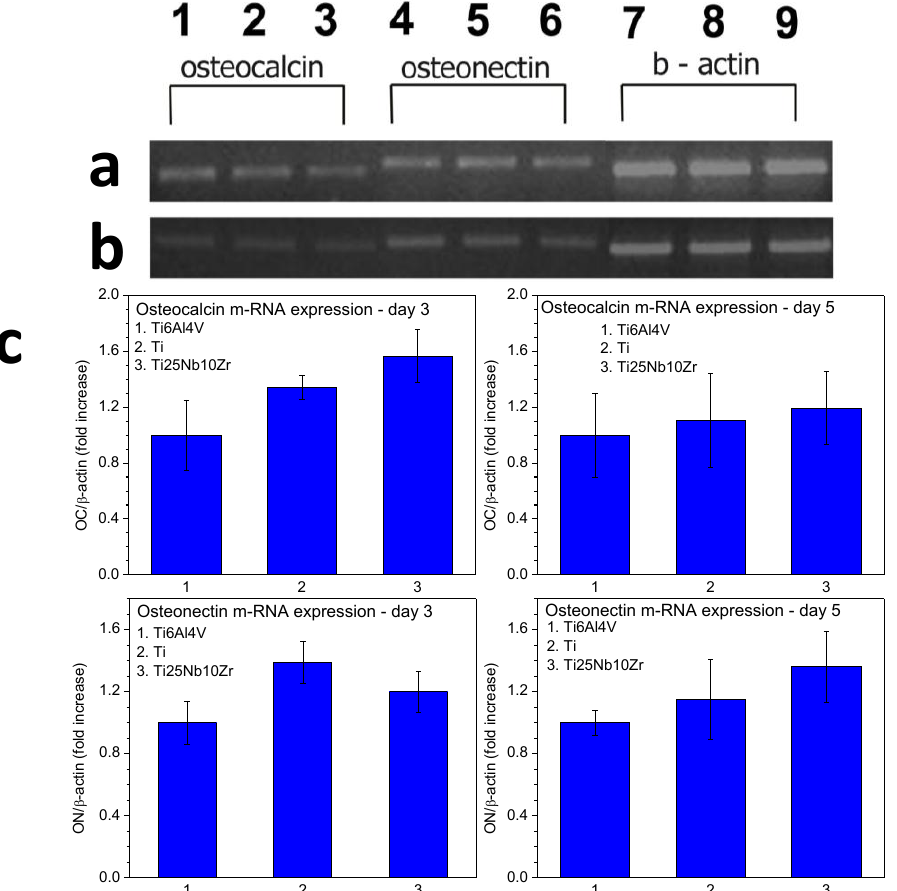
Figure 12. Alkaline phosphatase (ALP) activity in cells grown on the samples measured after 3 ( a ) and 5 ( b ) days of culture.